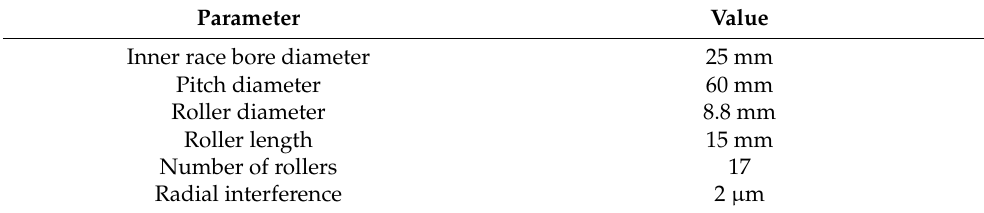
Table 1. Bearing Specification.